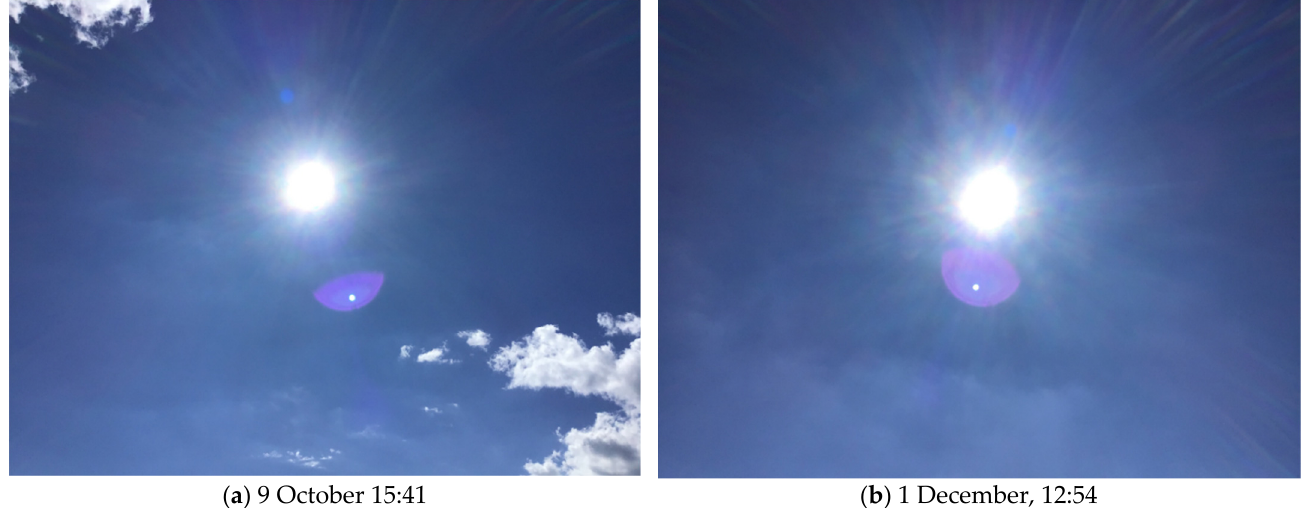
Figure 15. Weather conditions for the two observations at the solar altitude angle of 41.263 ° .